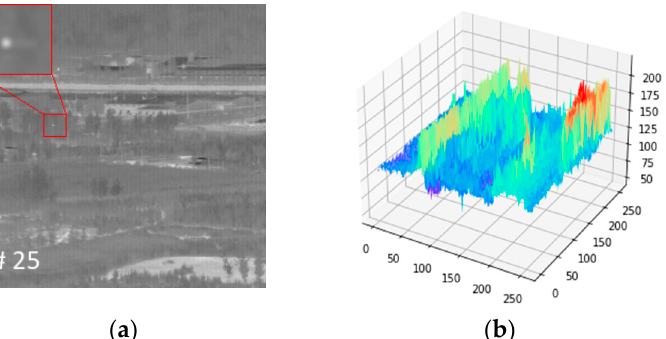
Figure 2. A single frame from the from the 5000 m distance video. The target is shown with a red rectangle. ( a ) The original infrared image; ( b ) the pixel distribution of the frame.